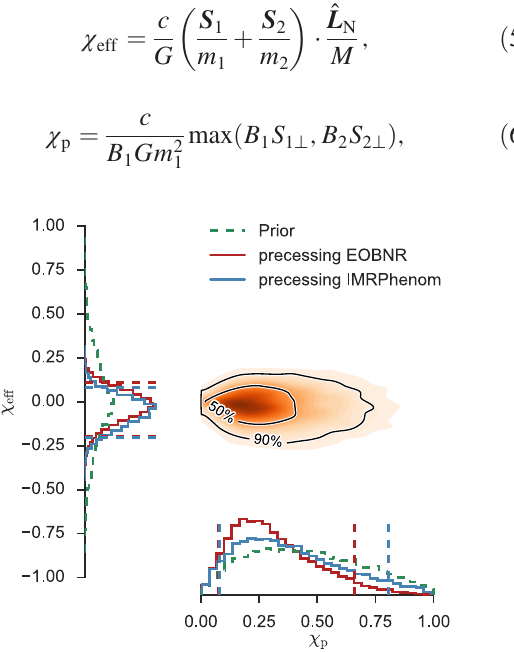
FIG. 6. Posterior probability densities of the opening angle between the two spins, θ 12 , and the angle between the in-plane projections of the spins, ϕ 12 . (See Fig. 2 for